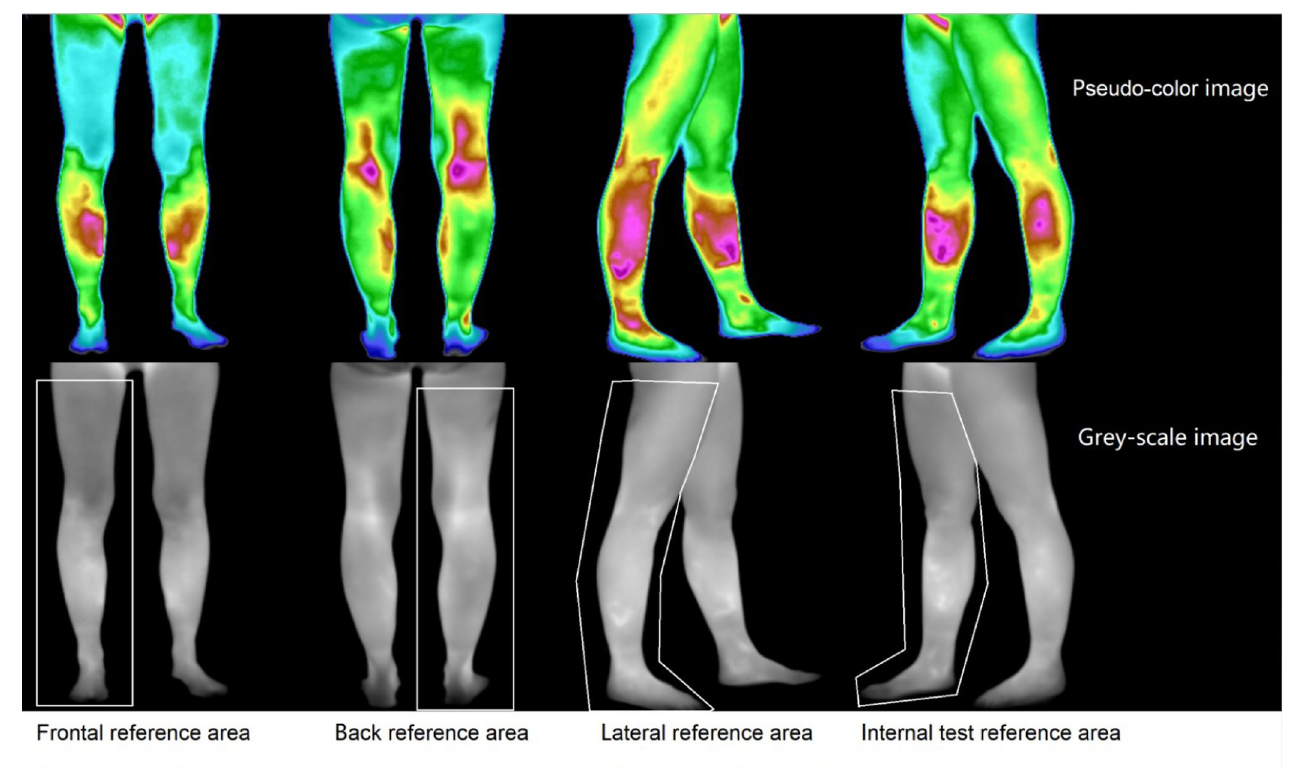
Fig 4. The location of reference